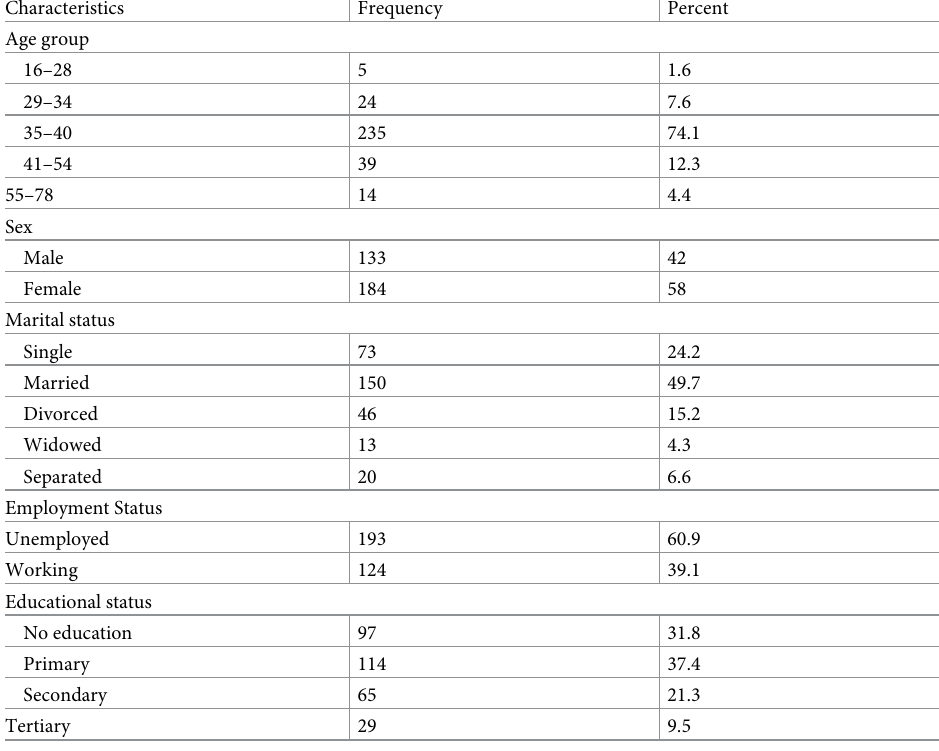
Table 1. Socio-demographic characteristic of patients started HAART at Ayder Referral Hospital, Mekelle, Ethio- pia. (n = 317) January 2009 to May 2012.